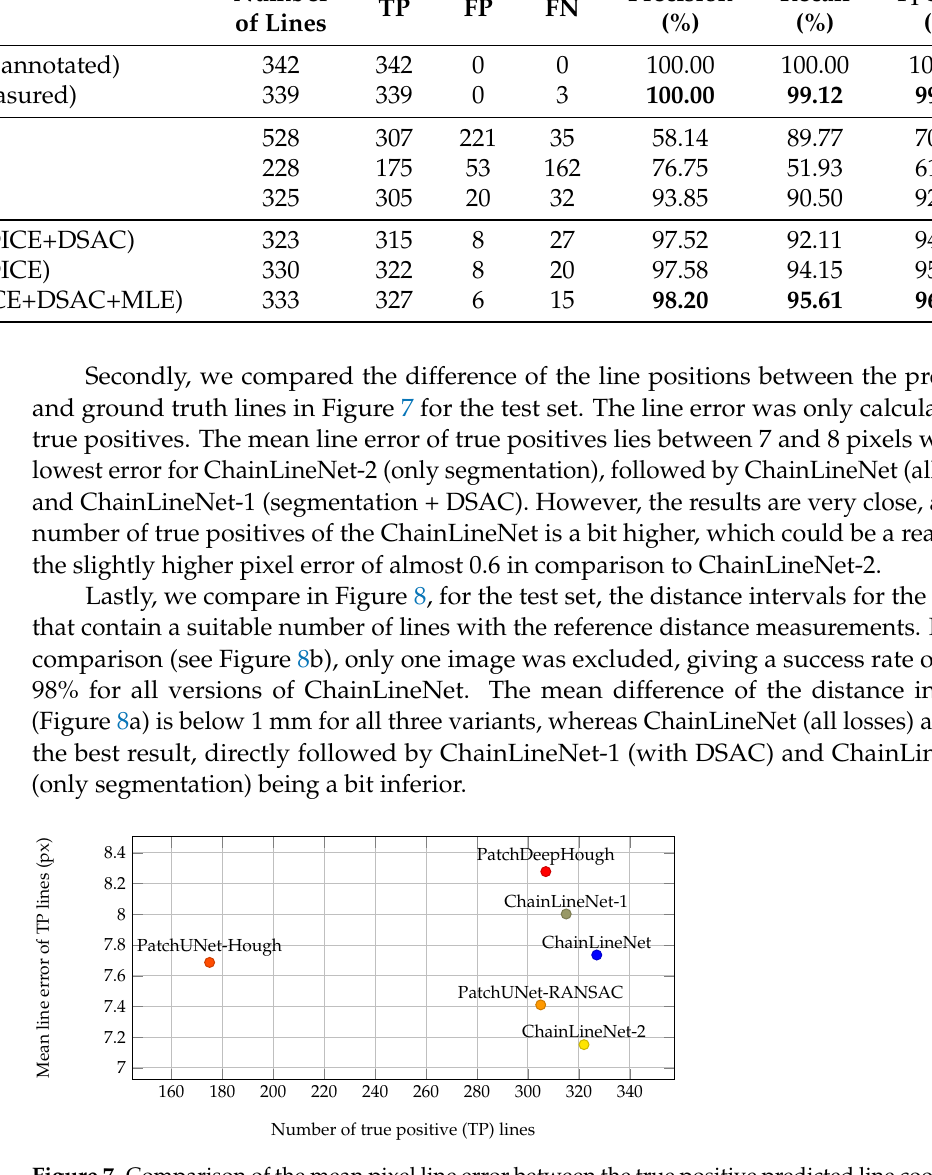
Figure 7. Comparison of the mean pixel line error between the true positive predicted line coordinates and the ground truth line coordinates for the test set. Our ChainLineNet (complete task loss) is compared to the end-to-end training with the task losses BCE+DICE+DSAC (ChainLineNet-1), to the training using only the segmentation task losses BCE+DICE (ChainLineNet-2), and to the competing